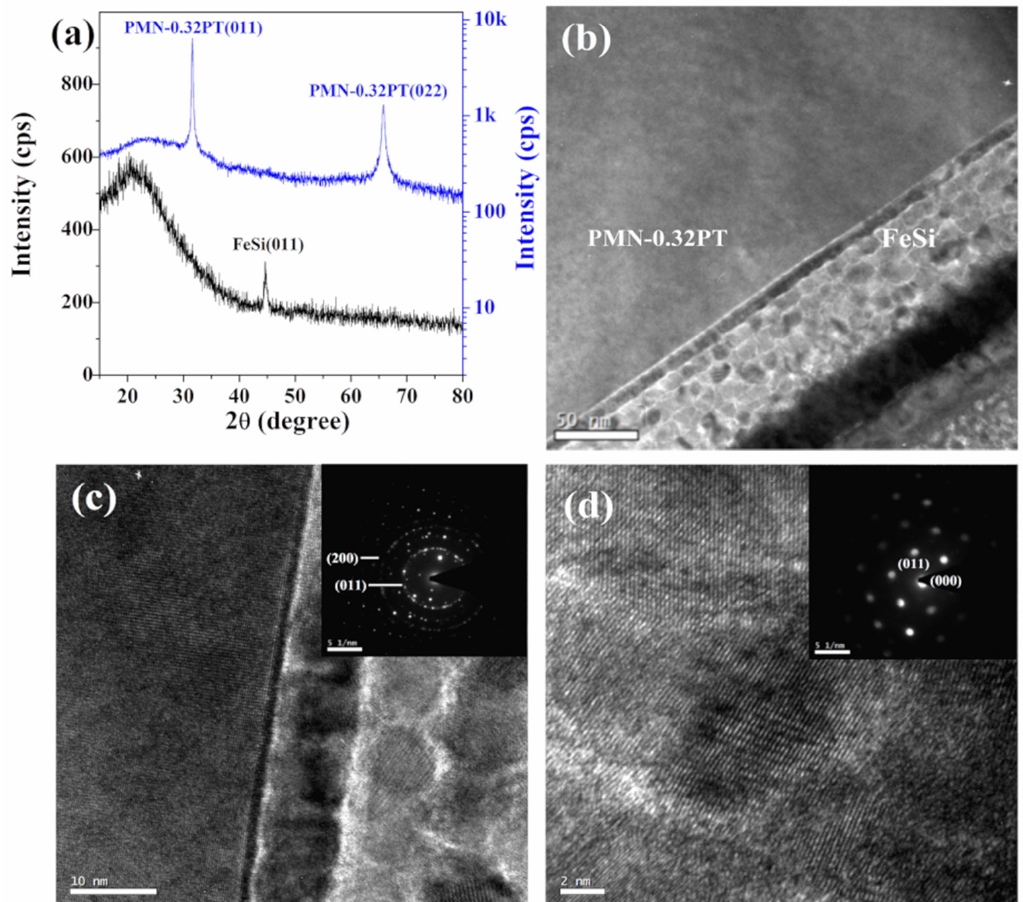
Figure 2. ( a ) X-ray di ff raction (XRD) patterns of FeSi / (011) PMN-0.32PT and FeSi / (011) PMN-0.3PT heterostructures. ( b , c ) Low-magnification TEM cross-section of FeSi / (011) PMN-0.32PT heterostructures. ( d ) High-resolution TEM image of the FeSi films. The insets in ( c , d ) show the corresponding selected area electron di ff raction (SAED)